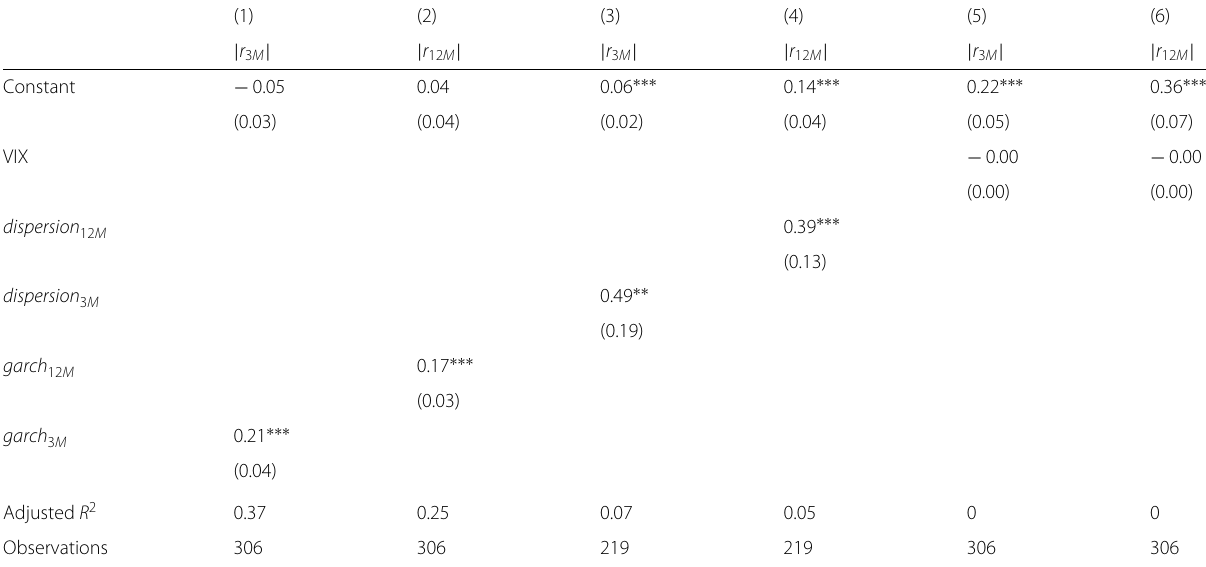
Table 5 Uncertainty and the size of the absolute term